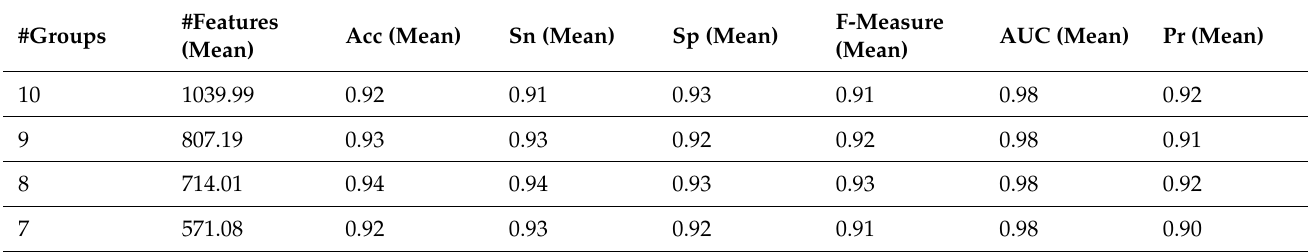
Table 2. Performance results of the AMP-GSM approach on the Gram-negative dataset of Dataset 1 (for 12 groups and 100-fold MCCV)